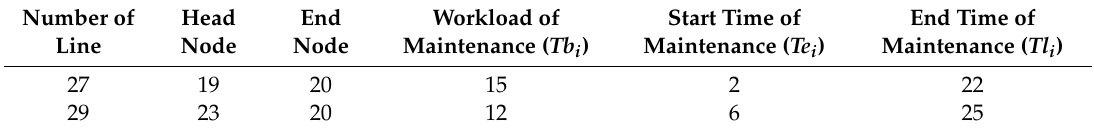
Table 5. Information of the transformers to be maintained in Hubei Province.